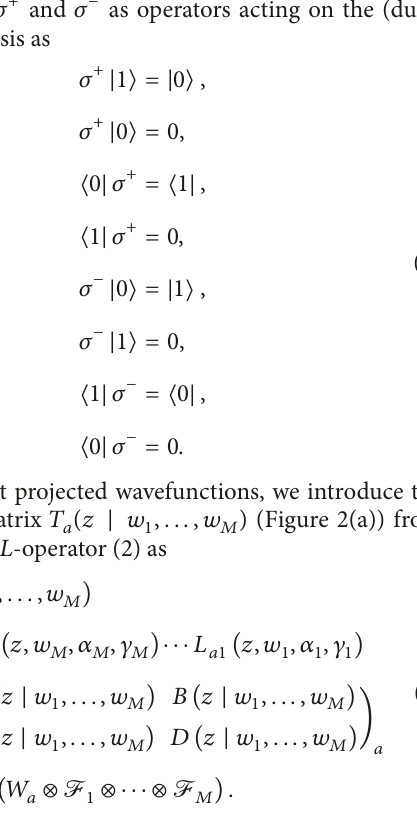
giving the Schur functions [9] and factorial Schur